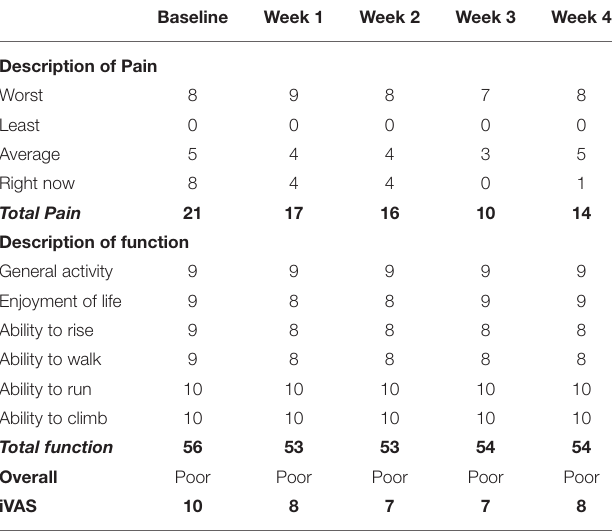
TABLE 1 | Scoring of Canine Brief Pain Inventory (CBPI; scale total pain 0–40, scale total function 0–60) by owners and interactive Visual Analog Scale (iVAS; scale 0–10) by an anesthesiologist in a 14-year-old dog suffering from bilateral hip and elbow osteoarthritis and severe neck pain, before and after liposomal cannabidiol subcutaneous